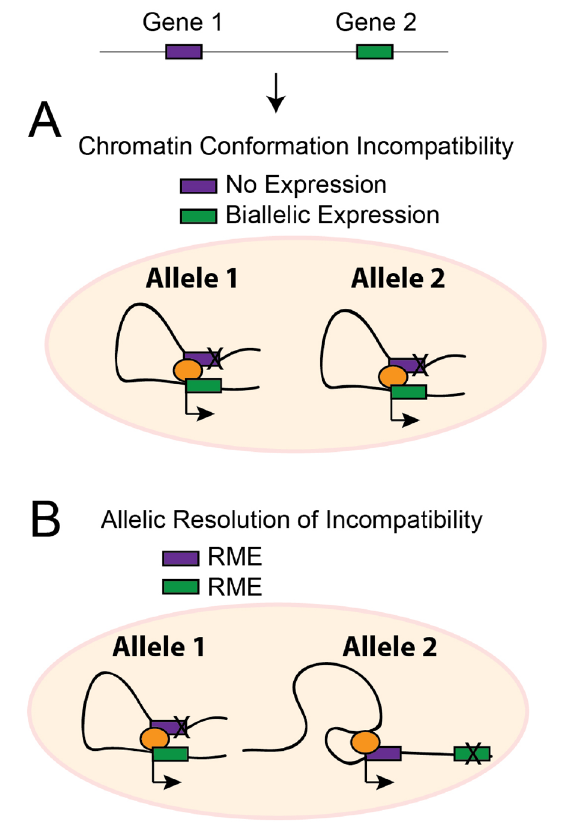
Figure 7. Random monoallelic expression (RME) effects may resolve chromatin conformation incompatibilities in the genome, allowing the activation of diverse gene regulatory networks across a cell population. A schematic representation of a chromatin incompatibility that influences the cellular expression of two genes is shown. Gene 1 and gene 2 compete for a particular chromatin state for their expression. ( A ) In the absence of RME effects, only one gene can win and is expressed in a biallelic manner in a cell. ( B ) However, if RME effects are present, then different chromatin structures can form on each allele to resolve the incompatibility and permit the simultaneous expression of both genes in the same cell. This model of RME effects implies that these effects may function to allow cells in a population access to diverse potential gene regulatory networks, thereby further contributing to cellular